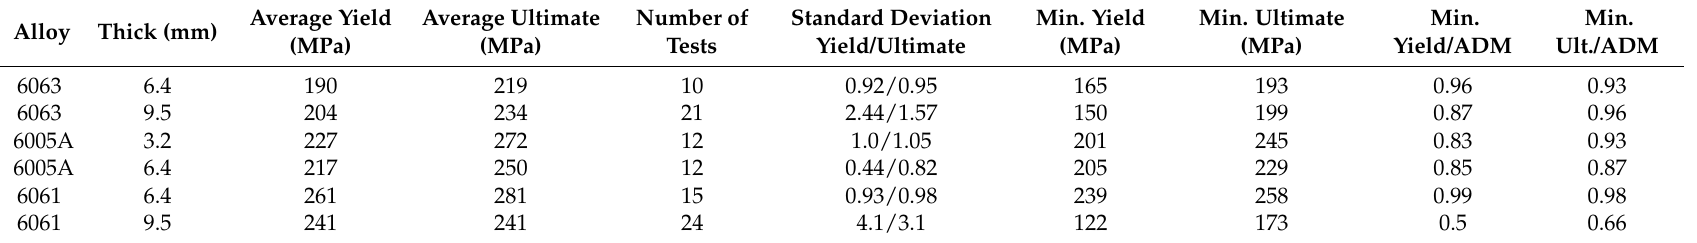
Table 2. Data analysis summary—post weld heat treated (PWHT) yield and ultimate